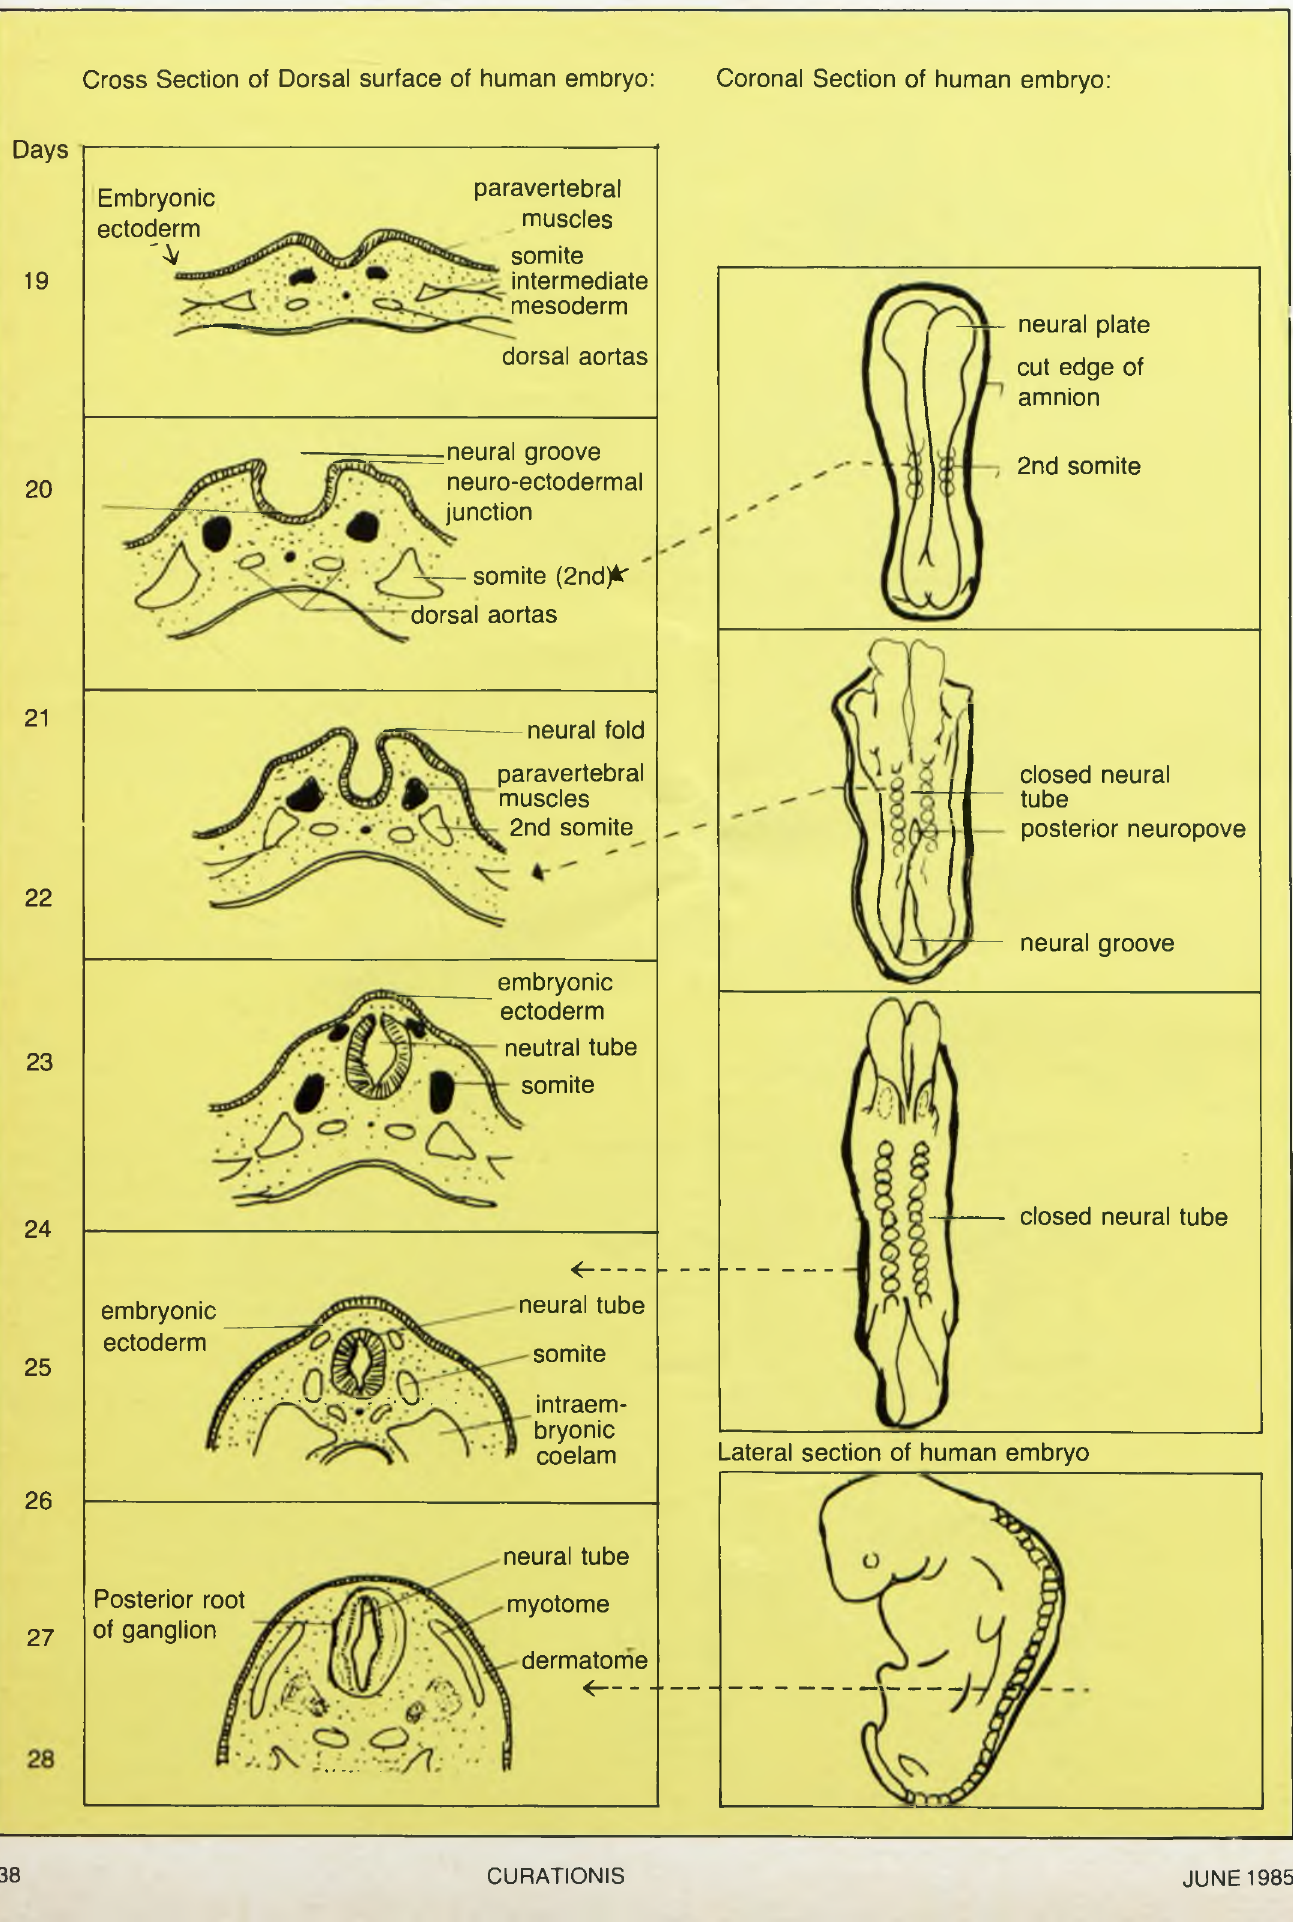
FIG 3: DIAGRAMATICAL REPRESENTATION OF EMBRYOGENESIS IN THE 4TH WEEK OF PREGNANCY (Day 19-28).